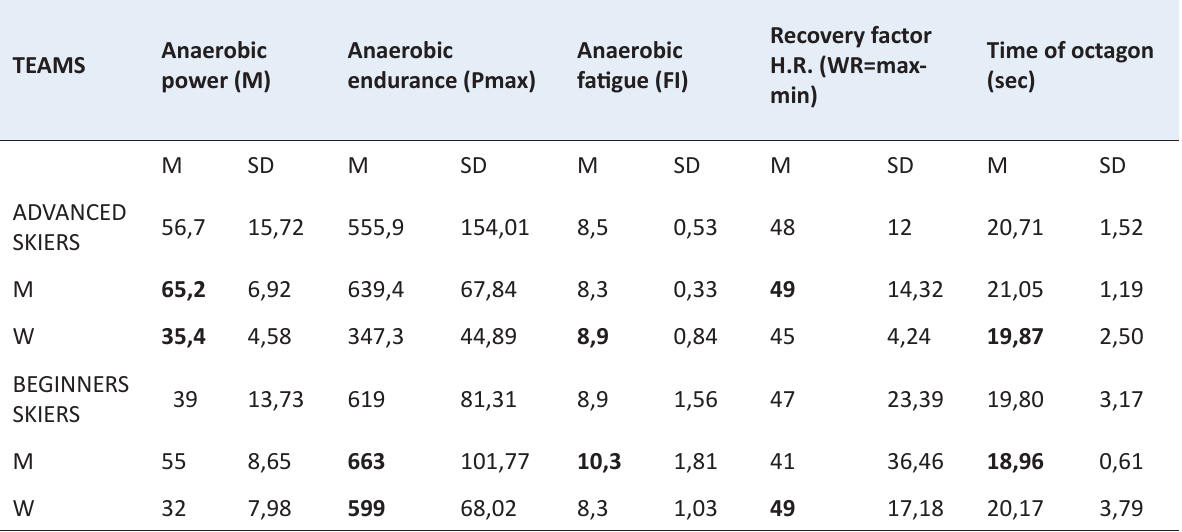
Table 3. The efficiency of anaerobic ability (power) of the advanced and beginners teams that participated in the slalom simulator test and the octagon bouncing off on dry ground